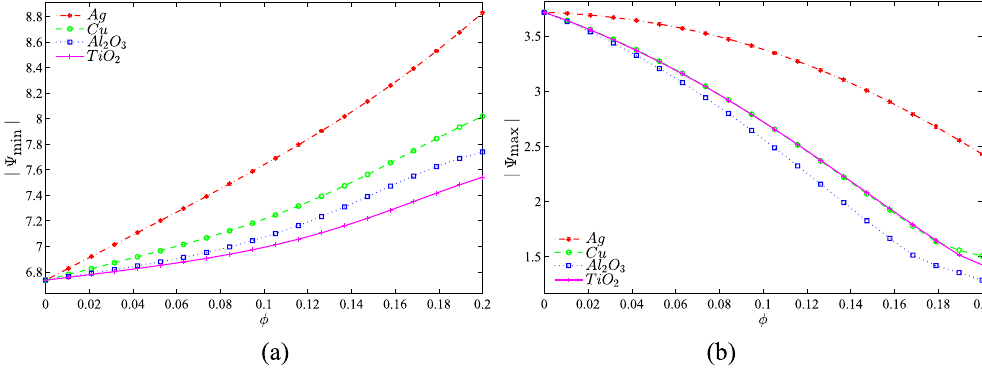
Figure 10. Values of the absolute ( a ) minimum and ( b ) maximum values of Ψ with φ for different nanoparticles